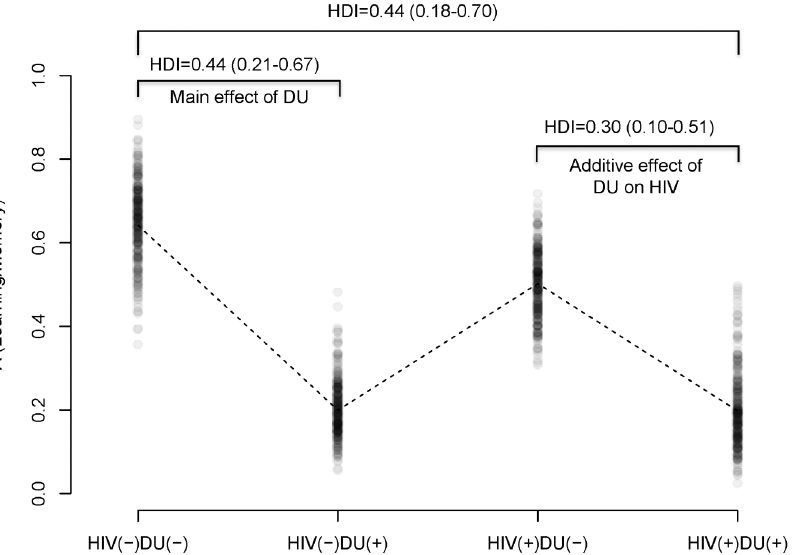
Figure 2. Parameter estimates of A (learning/memory). Note: 300 random samples were drawn from the posterior distributions for each group. Dashed lines indicate mean values for each group. HDI=mean and 95% HDI